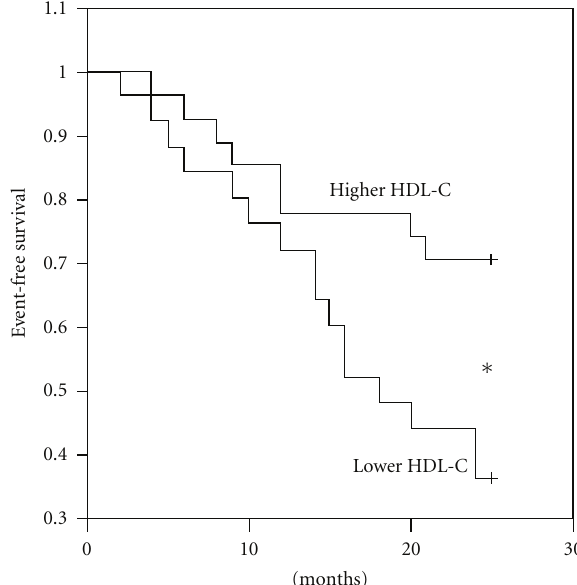
Figure 6: Kaplan-Meier analysis on diabetic hemodialysis patients showed that patients with higher HDL-C AI enjoy cardiovascular event-free lives longer than those with lower HDL-C. Log-rank test denoted that there was a significant di ff erence in cardiovascular events between the two